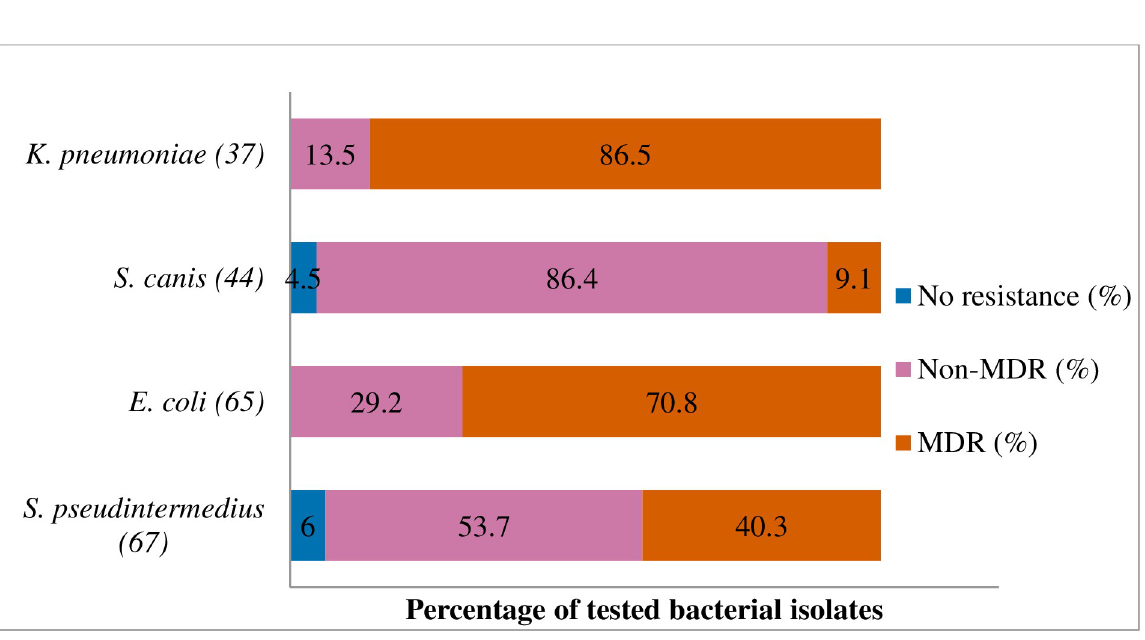
Fig 6. Multidrug resistance of clinically important bacterial pathogens from diseased cats between 2015 and 2017. Numbers inside brackets ‘()’ indicate the number of isolates detected; those on bars indicate percentage per organism; Non-MDR–Resistant to 1 or 2 classes; MDR–multi- drug-resistant, resistant to 3 or more